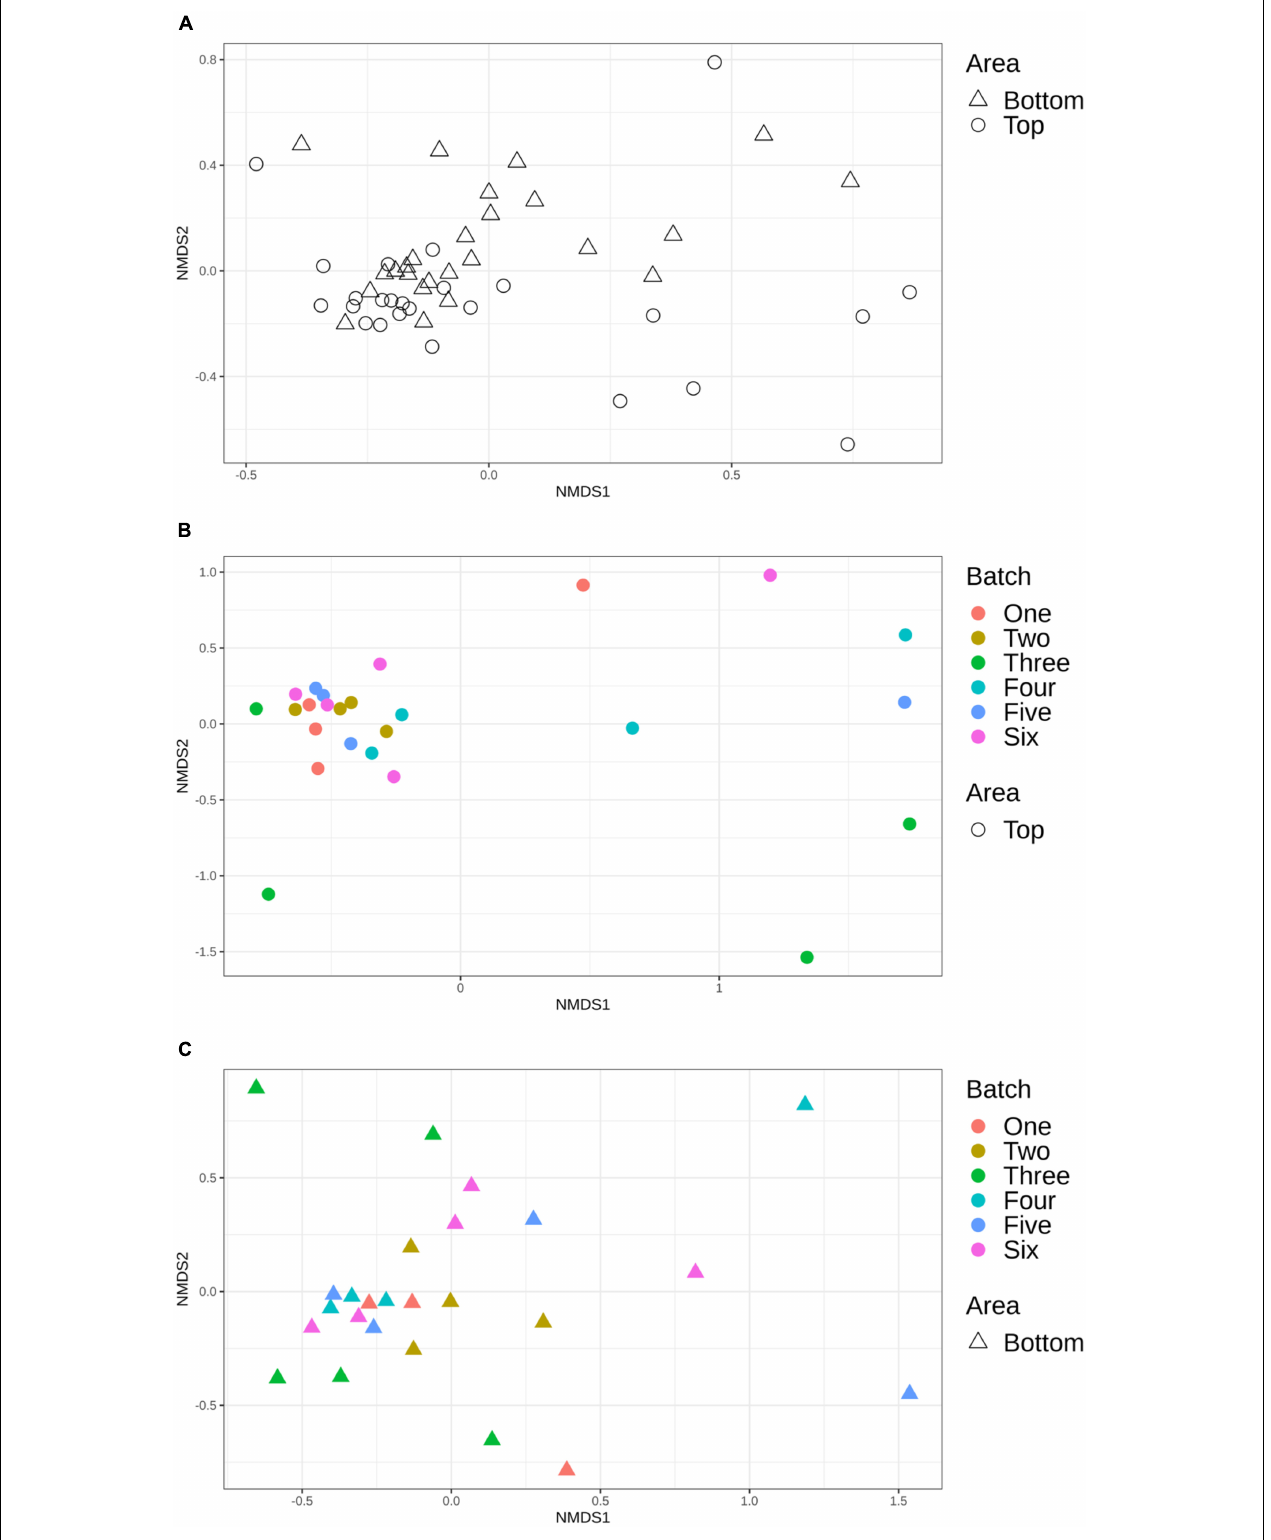
FIGURE 5 | Non-metric multidimensional scaling (NMDS) plot illustrating the microbiome structure of the pig carcass surface according to area (A) , top area according to batch (B) , and bottom area according to batch (C) .